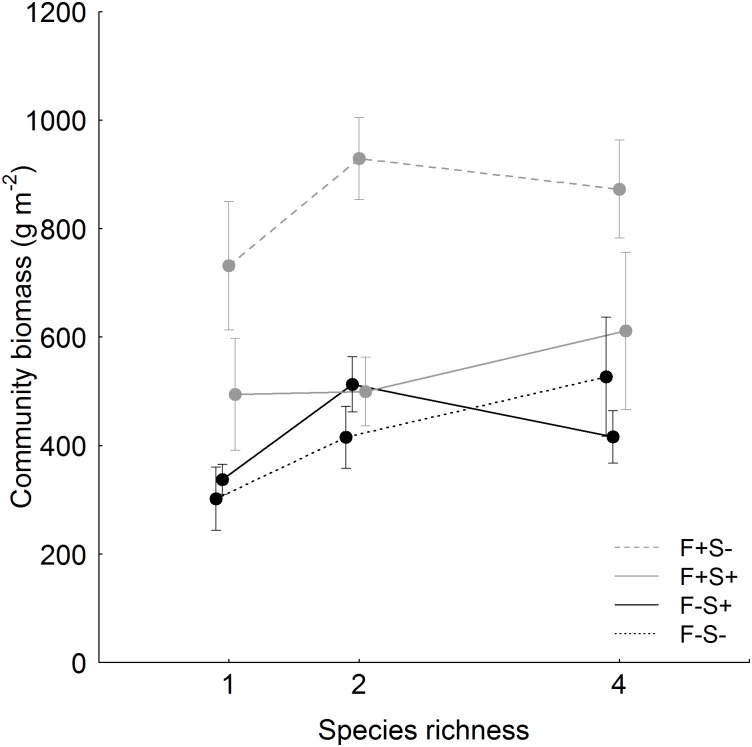
Effects of resource availability on aboveground biomass production in communities of different species richness.Values are means (± 1 SE) per resource treatment and species-richness level. Values are staggered along the x-axis for enhanced clarity. Treatments manipulating resource availability are abbreviated with: F-S- = no fertilization, no shading, F-S+ = no fertilization, shading, F+S- = fertilization, no shading, and F+S+ = fertilization, shading.